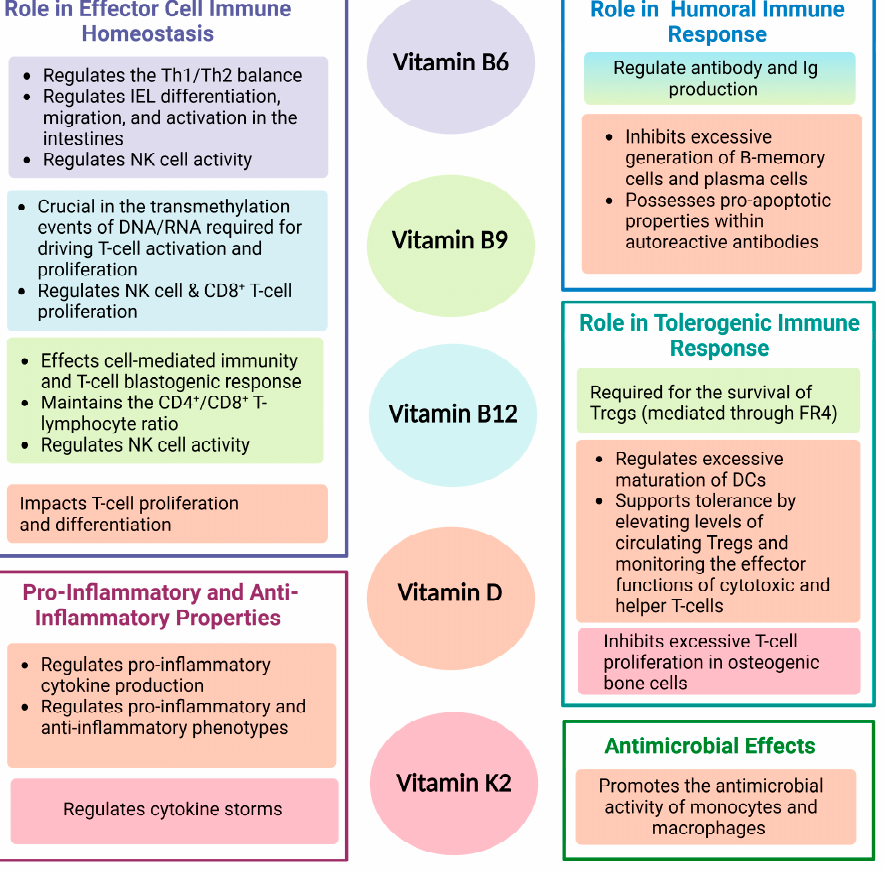
Figure 5. Summary of the Immune Functions of Vitamins B6, B9, B12, D, and